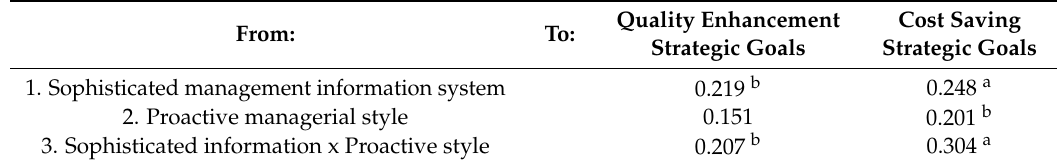
Table 3. Results from PLS analysis (path